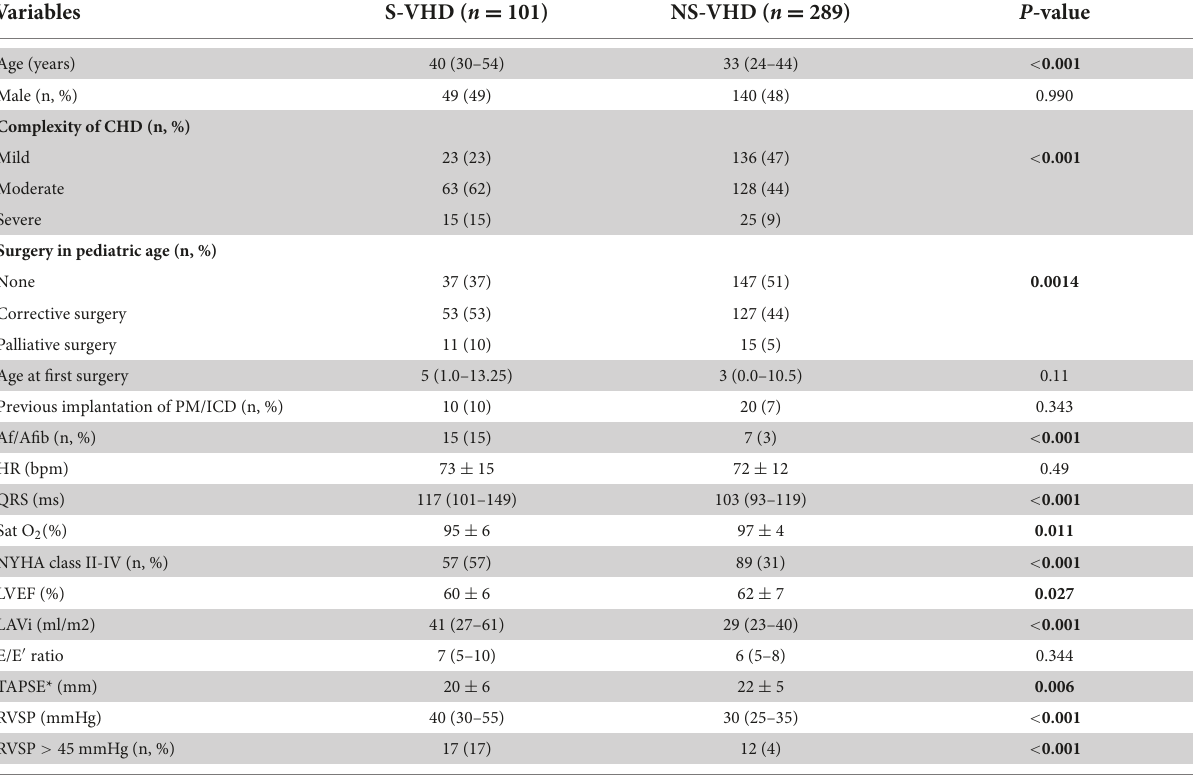
TABLE 2 Comparison between severe valvular heart disease (S-VHD) vs. NS-VHD patients.